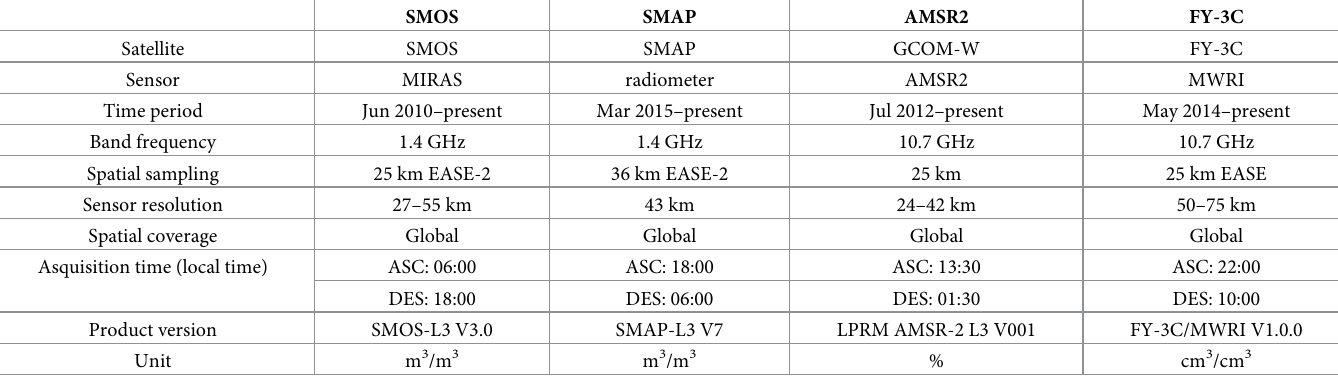
Table 1. Overview of the four satellite soil moisture datasets being